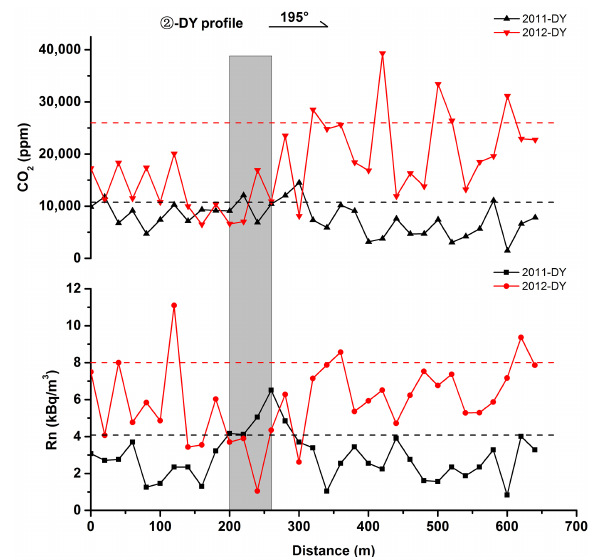
Figure 5. Rn and CO 2 concentrations along the DY profile across the Xinbaoan–Shacheng Fault. The shaded bar represents the lo- cation of the fault. The black and red dotted lines represent the anomaly threshold of soil gas in 2011 and 2012, respectively. The arrow at the top (with number above) represents the direction of the